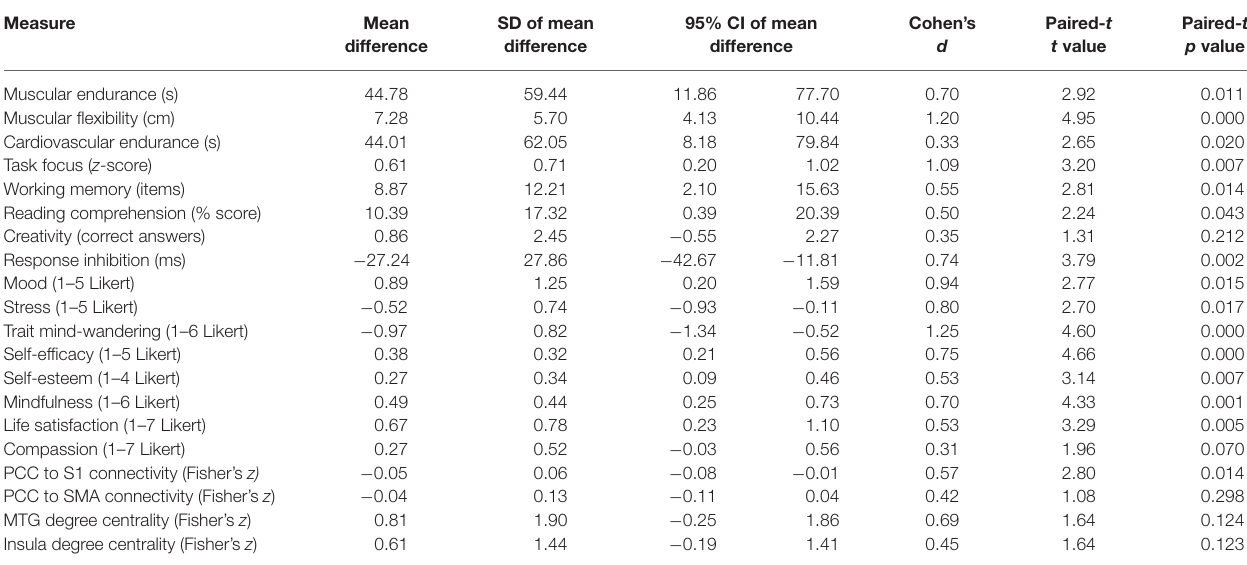
TABLE 2 | Persistence of training effects from baseline to 6-week